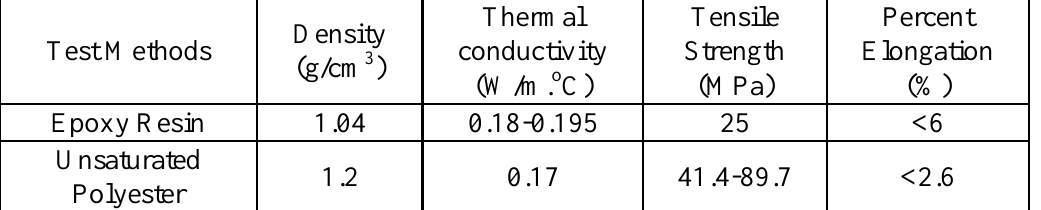
Table 1: Properties of epoxy resin and unsaturated polyester [5, 9].